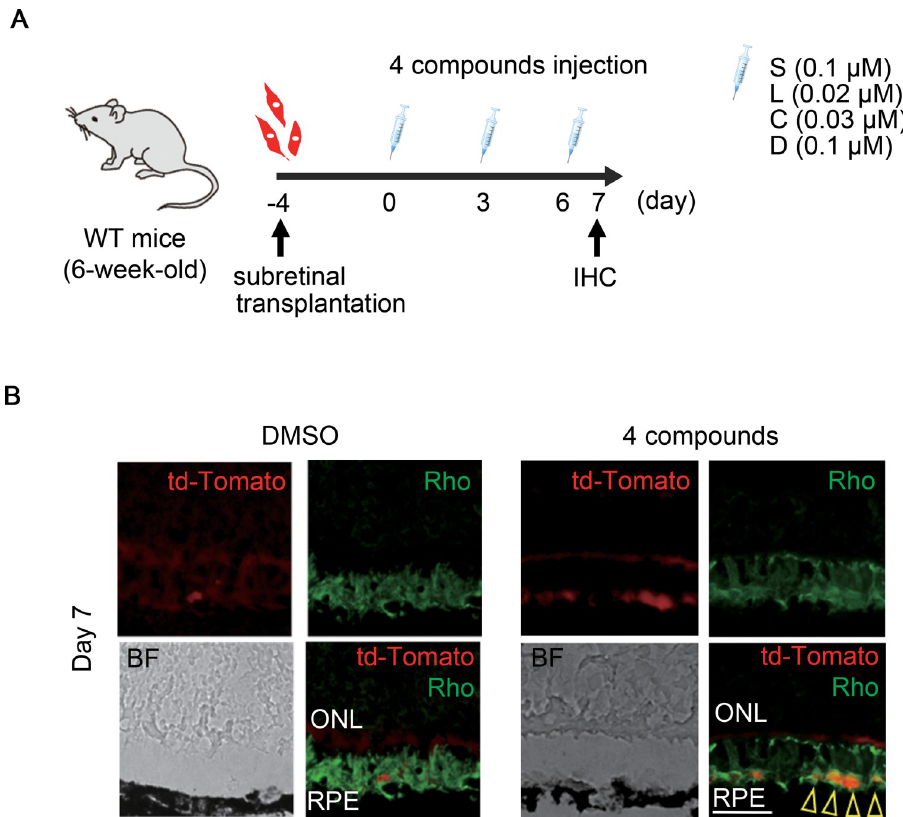
Fig 3. Rho expression in MCs transplanted into the subretinal space. A) Time course of the experiments. Td- tomato-positive MCs were transplanted into the subretinal space in 6-week-old WT mice. Injections of SLCD were administered every three days from day 4 after the transplantation. B) Immunohistochemistry of colocalization (yellow arrowheads) of td-Tomato (red) and Rho (green) on day 7 after SLCD stimulation (n = 5). Scale bar = 50 μ m.